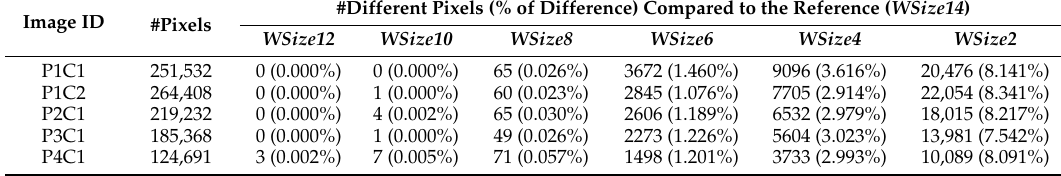
Table 4. Number of pixels with different classification result using the Euclidean distance between the different computed windows sizes and the reference one ( WSize14